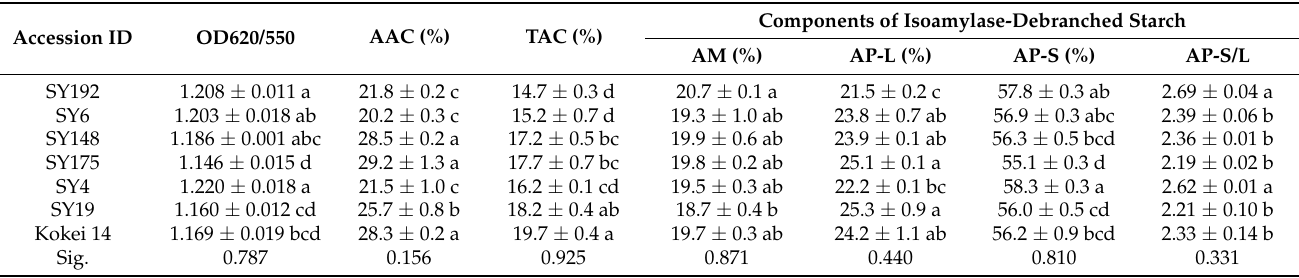
Table 2. Molecular components of C-type starches from different sweet potato